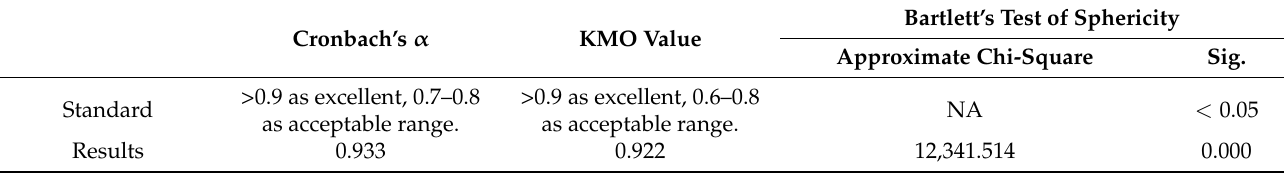
Table 5. Reliability and validity test results.